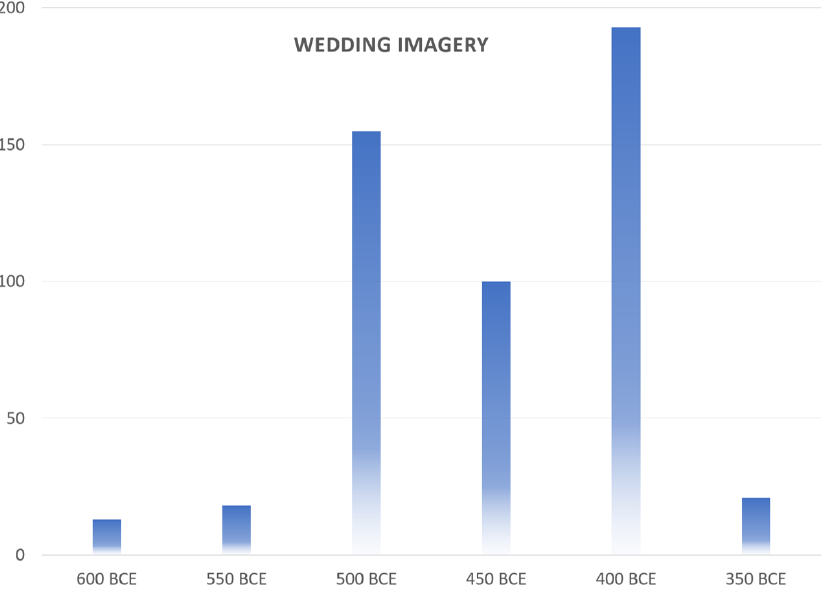
Figure 9. Depictions of weddings and wedding preparations on Athenian vases, including all known provenances. Data from the BAPD. Chart created by author.